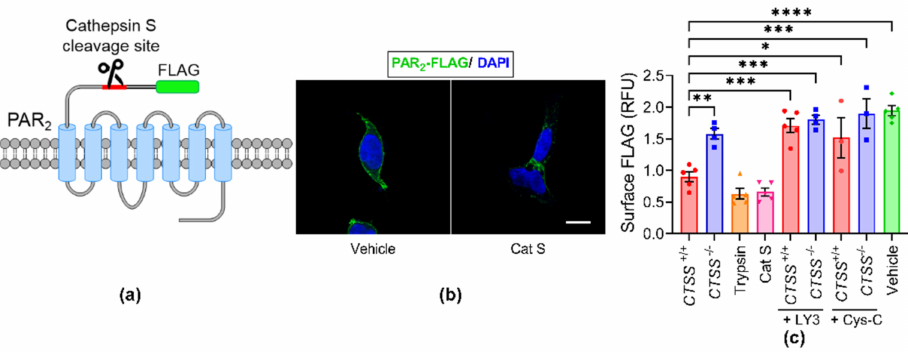
Figure 7. Cathepsin S cleavage of PAR 2 . ( a ) Human PAR 2 construct showing extracellular FLAG epitope and cathepsin S cleavage site. ( b ) Localization of PAR 2 using antibodies to extracellular N-terminal FLAG in HEK-FLAG-PAR 2 cells incubated with vehicle control (vehicle, left image) or cathepsin S (Cat S, right image). Scale bar, 10 µ m. ( c ) On-Cell Western assay shows that HSC-3 CTSS +/+ supernatant, trypsin, and cathepsin S remove the extracellular N-terminal FLAG epitope from HEK-FLAG-PAR 2 cells. LY3 and cystatin C (Cys-C) inhibit PAR 2 cleavage in HEK-FLAG-PAR 2 by HSC-3 CTSS +/+ and CTSS − / − supernatant. One-way ANOVA followed by Tukey’s multiple comparisons test, each data point representing the mean ± S.E.M., * p < 0.05, ** p < 0.01, *** p <0.001, **** p < 0.0001 ( n ≥ 3